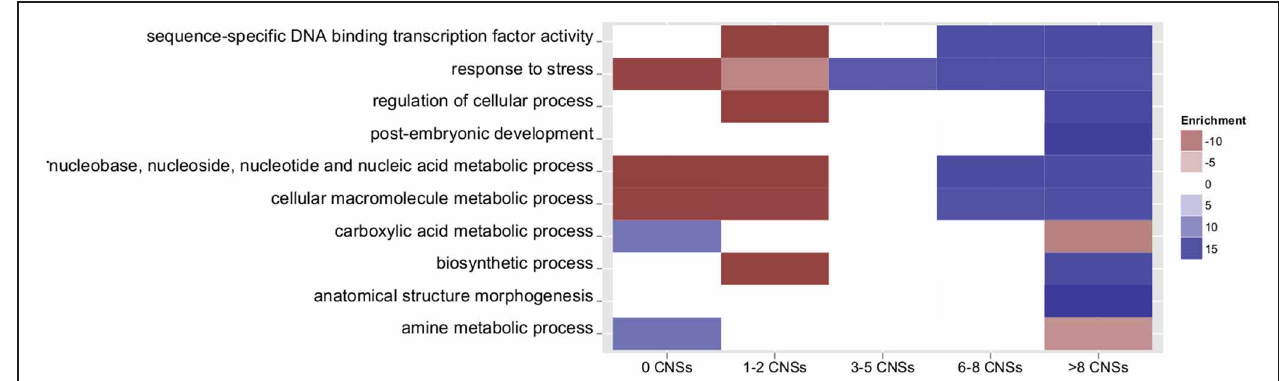
FIGURE 3 | Number of associated Os-Si CNSs and GO term enrichment for selected go terms. Only terms with a corrected p -value of ≤ 0.001 are counted as over- or under-represented. White blocks denote insignificant enrichment values. Colors indicate fold enrichment.